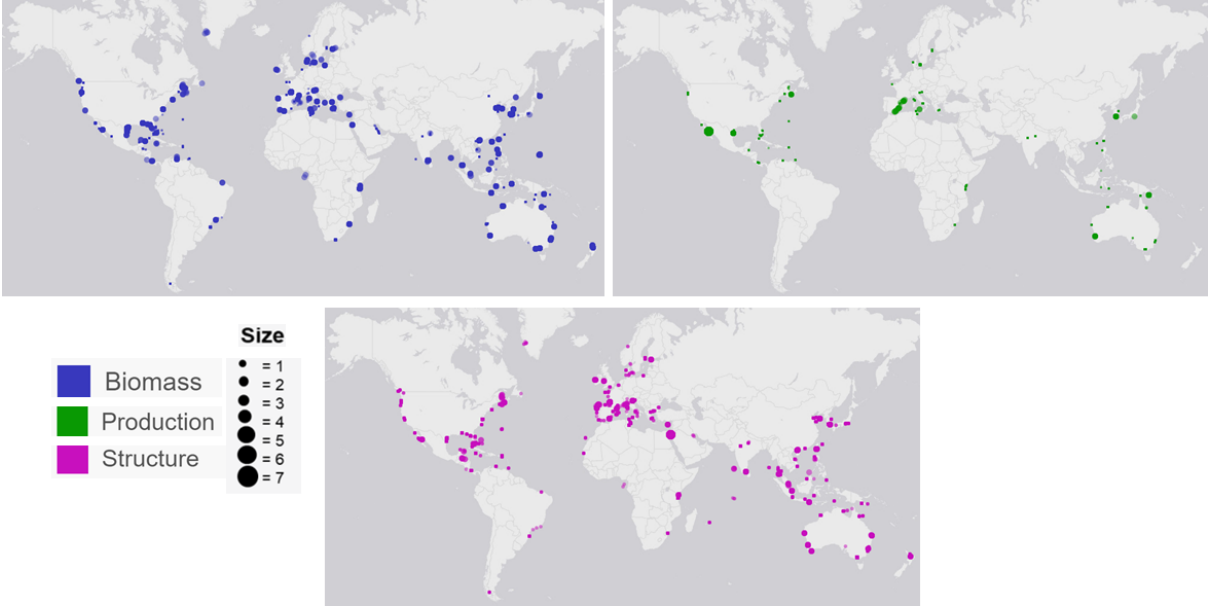
Figure 4. Global distribution map of seagrass study sites labelled as dots. The colours indicate the data type (biomass, production and structure), while the size of each dot illustrates the number of data points for each